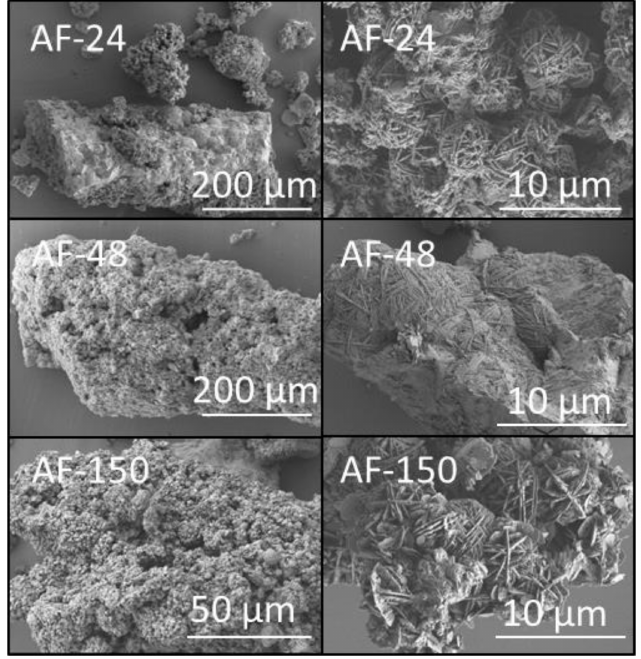
Figure 6. Secondary electron SEM images of hydrothermal products of amber container glass and